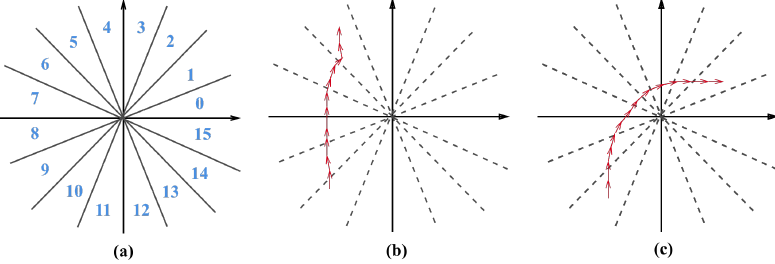
Figure 6. ( a ) The encoding and quantization of direction angles. ( b ) The changing angles of a vehicle going straight. ( c ) The changing angles of a vehicle turning